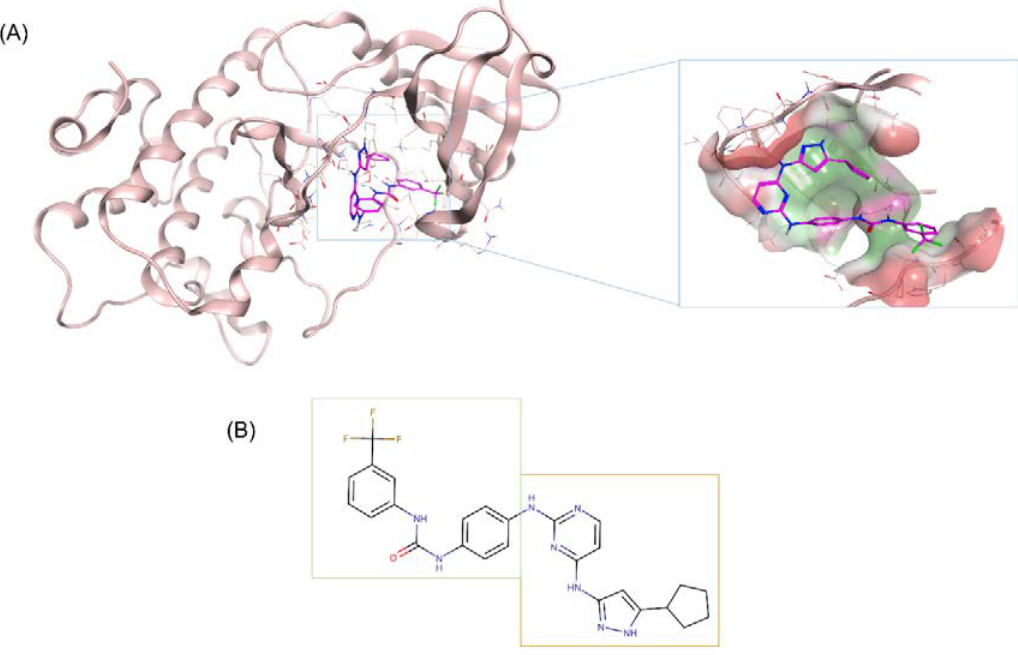
Figure 2. CD532’s binding mode to Aurora A kinase (AURKA). ( A ) CD532 (magenta sticks) binds to the active site of AURKA (pink ribbons). CD532 interacts with the ATP-binding hinge region, as well as with the protein-protein interactions (PPI) disruptor moiety, to induce conformation changes in AURKA (shown in the zoomed picture on right). Three-dimensional structure extracted from PDB 4J8M. Beta-sheets have been removed from the pocket for easier visualization of AURKA’s allosteric site. ( B ) CD532’s active sca ff old can be divided into two main portions. One responsible for the N-Myc PPI disruption (encased in green), while the other acts as an ATP-competitor sca ff old to bind to the hinge of AURKA (encased in